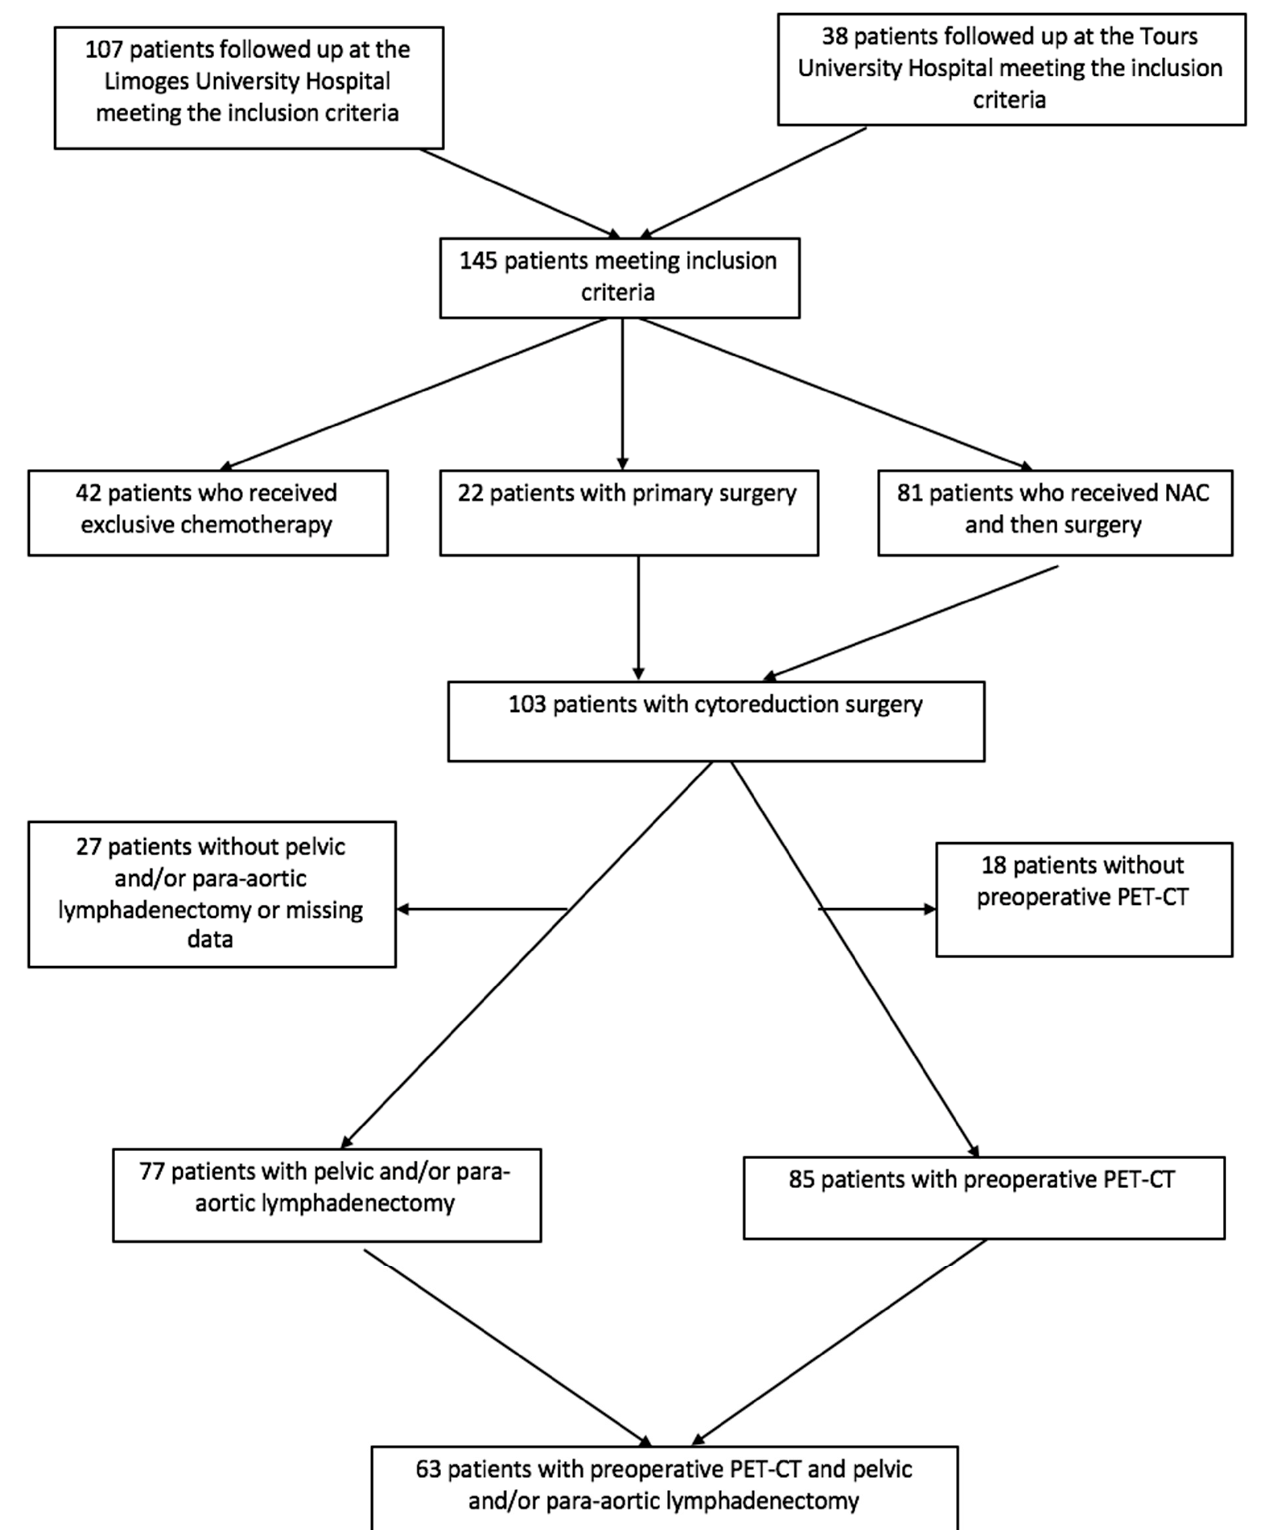
Figure 1. Flow Figure 1. Flow chart.